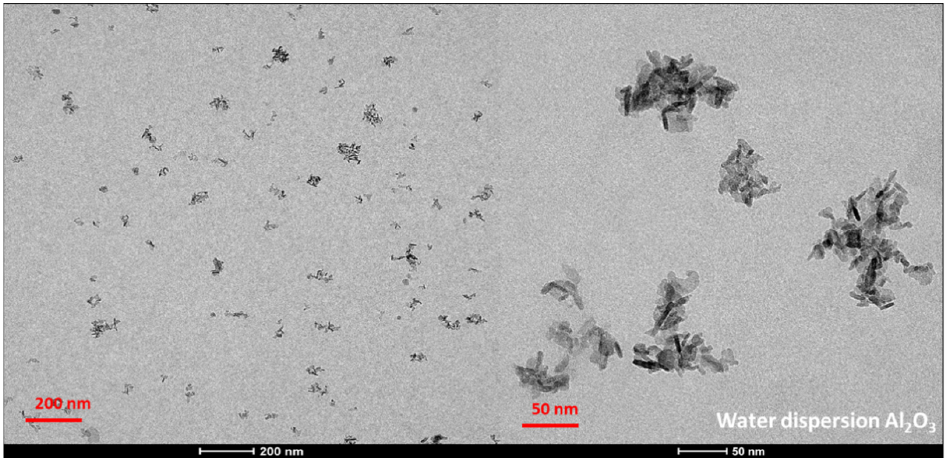
Figure 7. TEM micrographs of the reinforcing nanowire used (Al 2 O 3 ).